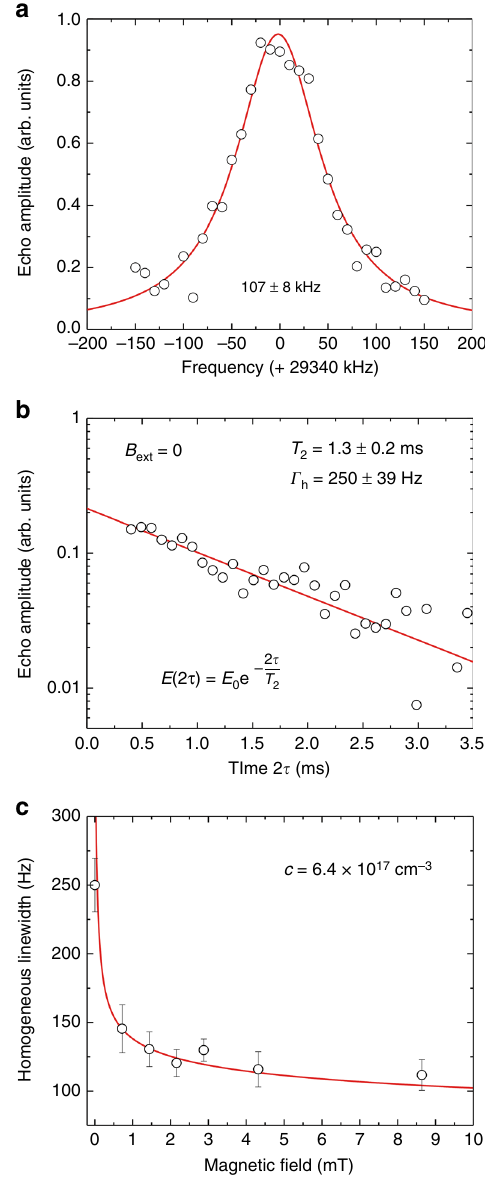
Fig. 2 151 Eu 3 + spin inhomogeneous and homogeneous linewidths. a Inhomogeneous linewidth of the ± 1 = 2 ij $ ± 3 = 2 ij spin transition obtained by monitoring the spin-echo amplitude as a function of the frequency detuning ω 2 – ω 1 for a fi xed time delay 2 τ of 400 µ s (circles). Solid line: Lorentzian fi t corresponding to a full width at half maximum of 107 ± 8 kHz. b Spin-echo decay at zero magnetic fi eld. A single-exponential fi t yields a coherence lifetime T 2 of 1.3 ± 0.2 ms, corresponding to a Γ h = 250 Hz homogeneous linewidth. c Homogeneous linewidth evolution under an applied external magnetic fi eld. A fast decrease in Γ h is observed for weak fi elds, corresponding to a coherence lifetime increasing from 1.3 ms to 2.9 ms (Supplementary Fig. 6). Solid line: modelling by interactions with defects carrying electron spins at a concentration of 6.4 ×10 17 cm − 3 (see Supplementary Discussion). Error bars and uncertainties correspond to ±1 standard